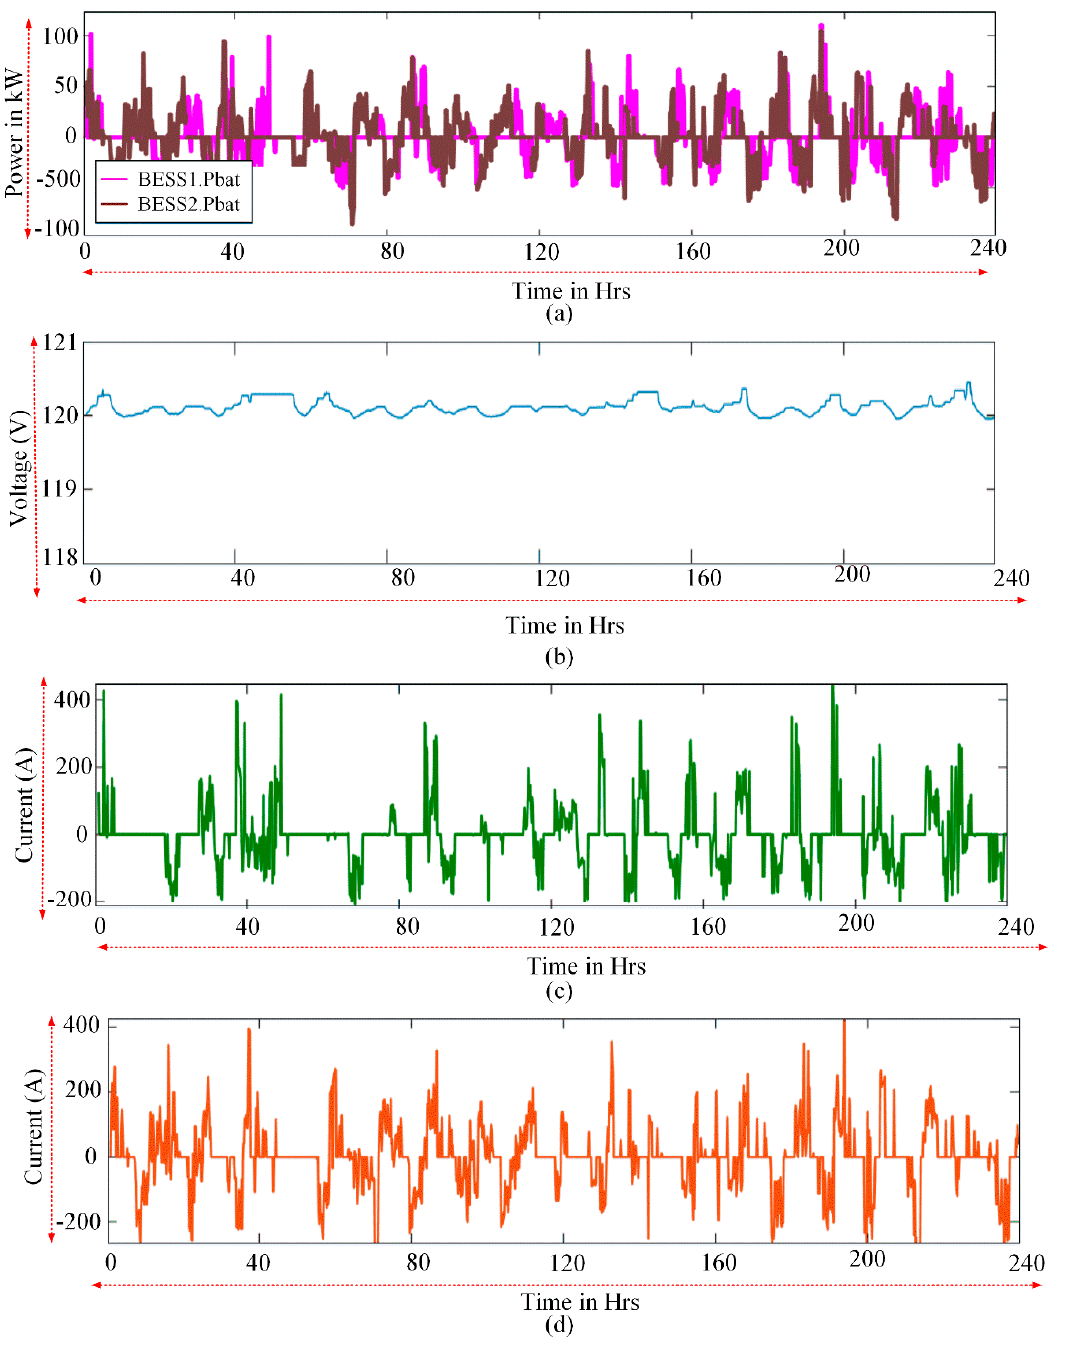
Figure 9. ( a ) Power Charged or Discharged by Dual battery modules BESS 1 and BESS 2 . ( b ) BESS 1 and BESS 2 discharging voltage. ( c ) BESS 1 charging and discharging current ( d ) BESS 2 charging and discharging current for discharging.